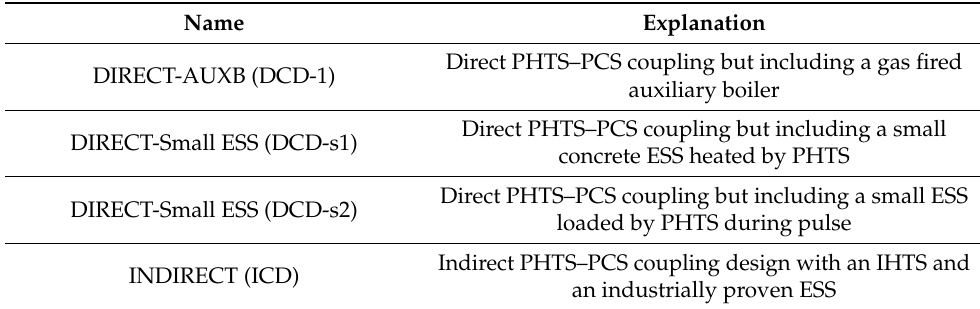
Table 1. DEMO HCPB BOP variants investigated during pre-conceptual design phase [5].